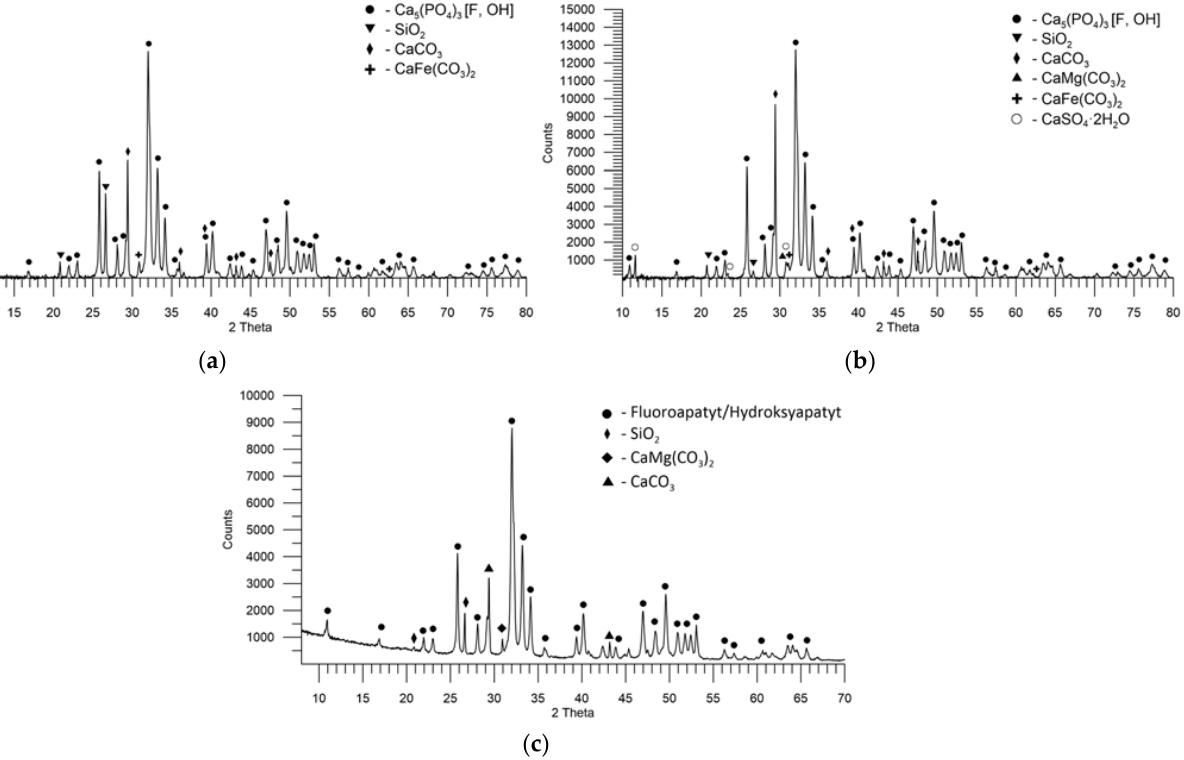
Figure 5. XRD pattern of PRs from various deposits: ( a ) PR2; ( b ) PR3; ( c ) PR5.